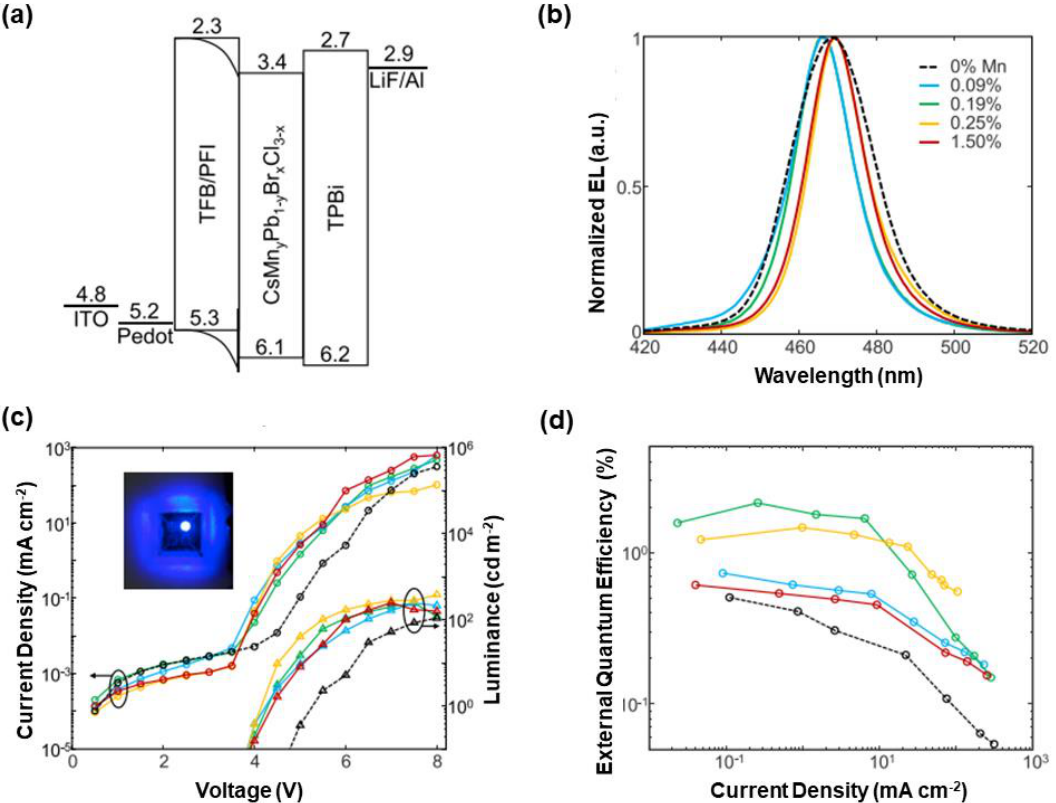
Figure 9. ( a ) Device architecture and energy levels of PeLEDs. ( b ) EL spectra of PeLEDs with varying Mn content. ( c ) Current density–voltage–luminance characteristics. Inset: an image of the 0.19% Mn device. ( d ) EQE of PeLEDs. Reproduced from reference [315].